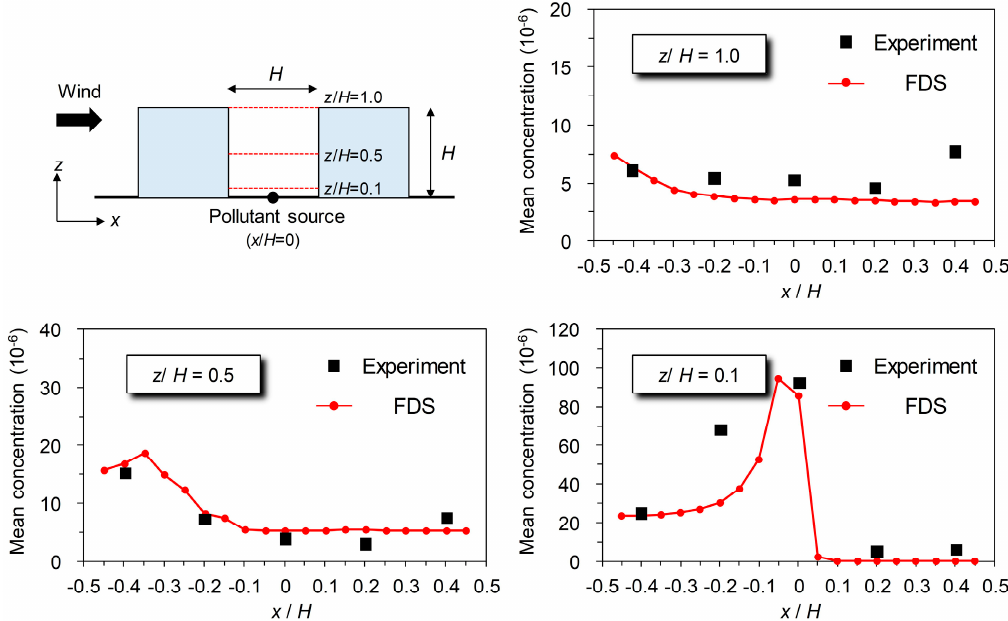
Figure 13. Distributions of mean concentration inside the street canyon at three different heights (center line).